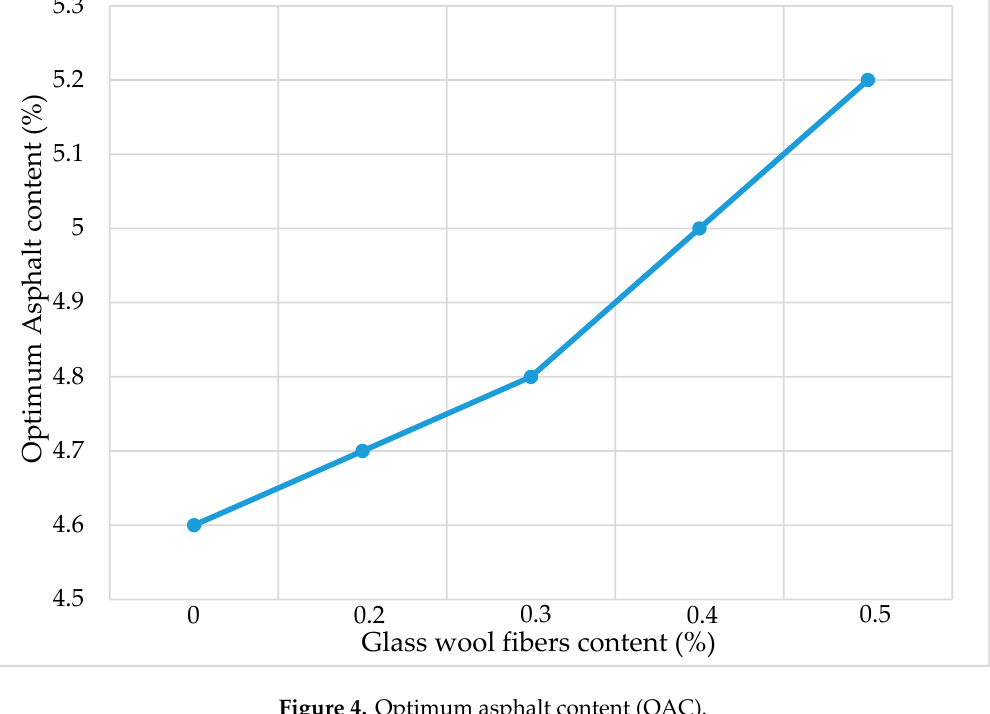
Figure 4. Optimum asphalt content (OAC).